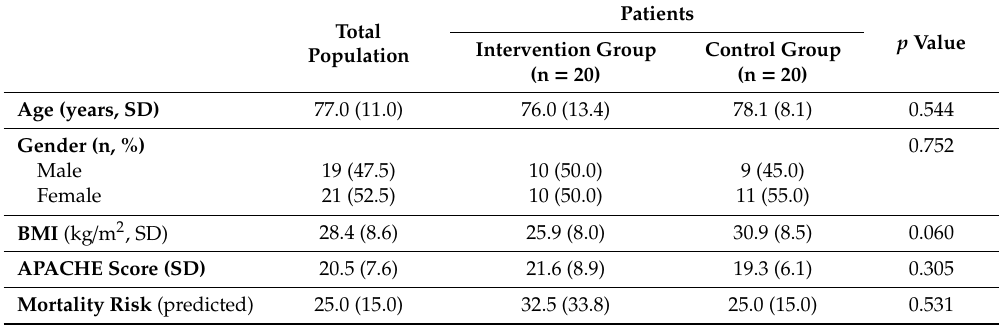
Table 1. Demographics, Apache score, predicted death rate, and comorbidities in the study